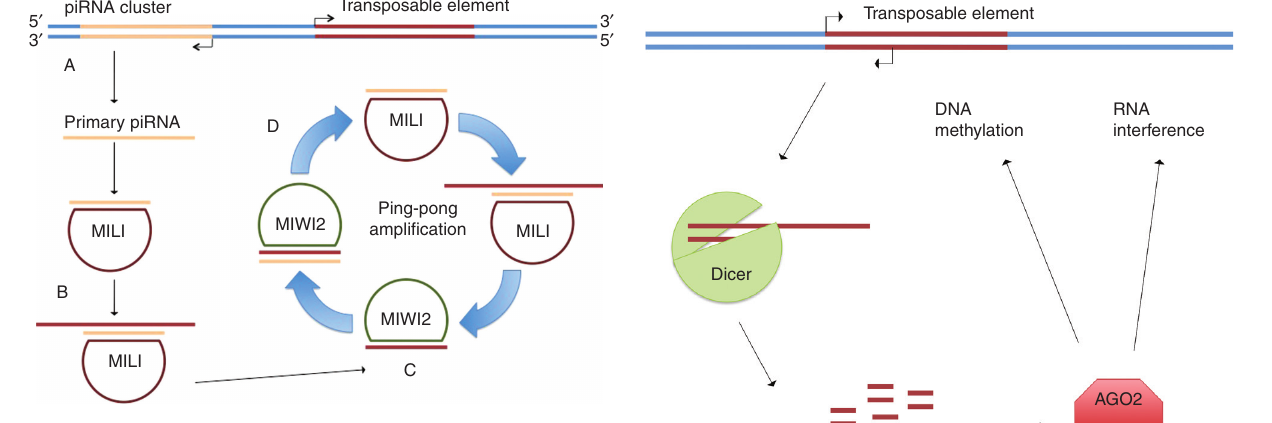
Figure 2 piRNAs and ping-pong amplification. (A) piRNAs targeting TEs are transcribed from piRNA clusters. (B)